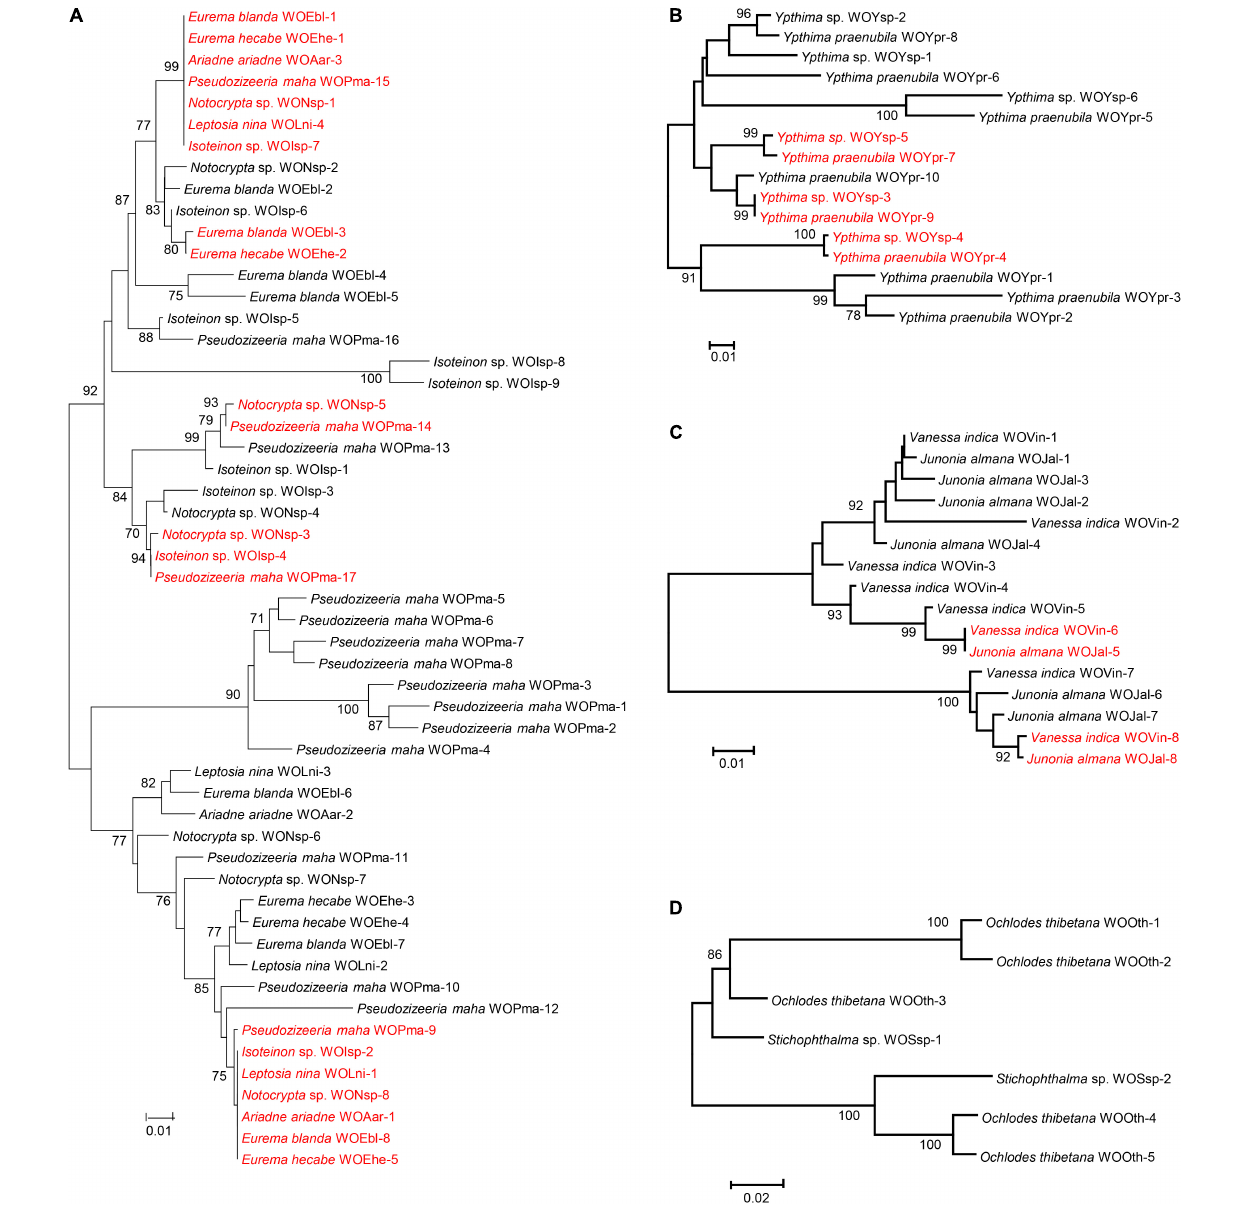
FIGURE 1 | Maximum likelihood phylogenetic tree of the phage WO orf7 nucleotide sequences from Wolbachia strains ST-41 (A) , ST-19 (B) , ST-125 (C) and ST-374 (D) . Numbers above branches are bootstrap values computed from 1,000 replications. WOEbl-1 refers to phage WO type. Red font indicates identical orf7 sequences or those with similarity of orf7 sequences greater than 98.5% among their respective